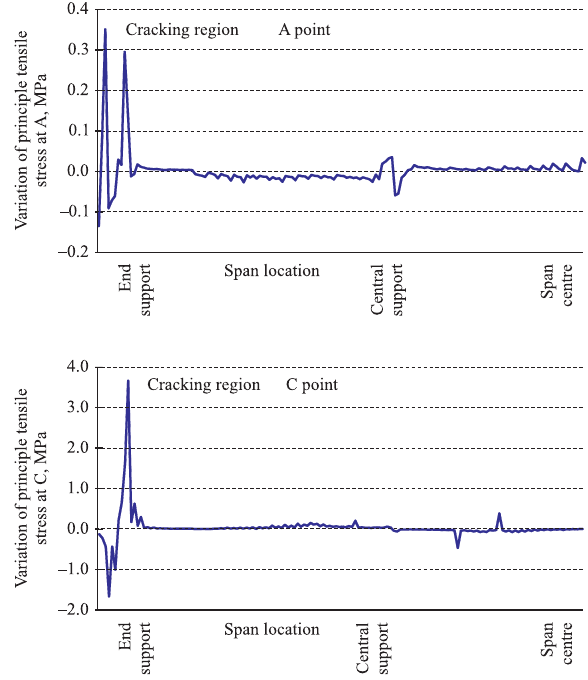
Fig. 17. The variation of max principal tensile stress of web after bottom slab cracking